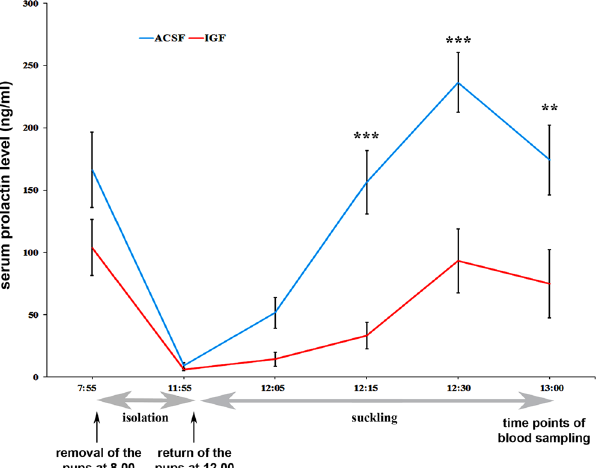
Figure 5. IGF-I administration significantly suppresses suckling-induced prolactin release. Blood was taken first at 8.00 AM, before the removal of the pups from their mother; second, right before the pups were returned after a 4-hour isolation period; the 3 rd , 4 th , 5 th and 6 th blood samples were obtained at 5, 15, 30 and 60 min after the pups were returned (start of suckling). The diagram shows the serum prolactin levels in mothers during the pup isolation-suckling protocol. The animals treated with IGF-I are shown in red (n = 7), while the ACSF- treated rats are shown in blue (n = 8). The x-axis shows time in a nonlinear fashion. Below the x-axis, the periods of pup separation and suckling are indicated with grey arrows. During the initial time point, before the isolation period, the plasma prolactin levels in the two groups of animals did not differ significantly as determined by Newman-Keuls post hoc test, even though a clear trend is visible for reduced levels in IGF-I treated animals. Without the litter, the prolactin levels dropped to an equally low basal value in both groups. Then, the plasma prolactin levels rose during suckling, but IGF-I administration significantly attenuated the elevation in plasma prolactin levels at 15, 30 and 60 min after the pups were returned ( *** p < 0.001; ** p < 0.01, t = 4.124, t = 4.804 and t = 3.322, respectively). The results are presented as the mean values ±